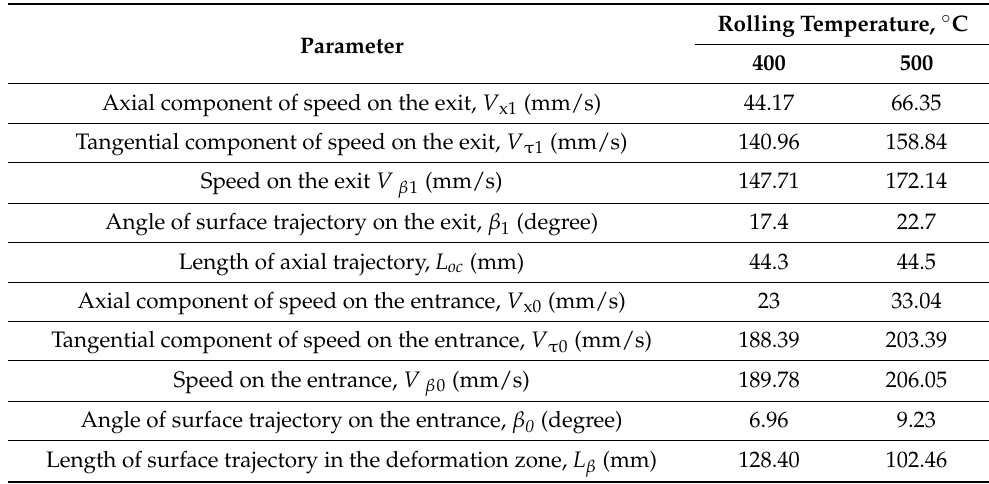
Table 2. Trajectory and speed parameters of RSR at different